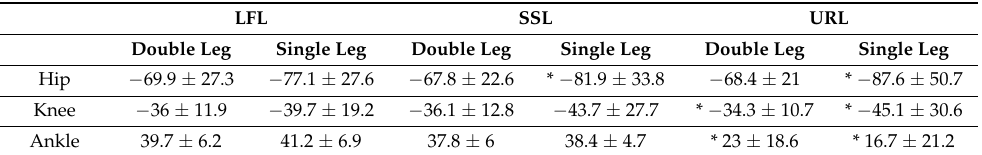
Table 3. Descriptive statistics and results of 2-way repeated measures ANOVA (Mean ± SD) compar- isons of sagittal plan trunk angles (LFL, SSL and URL) and hip, knee and ankle flexion angles during double/single-leg